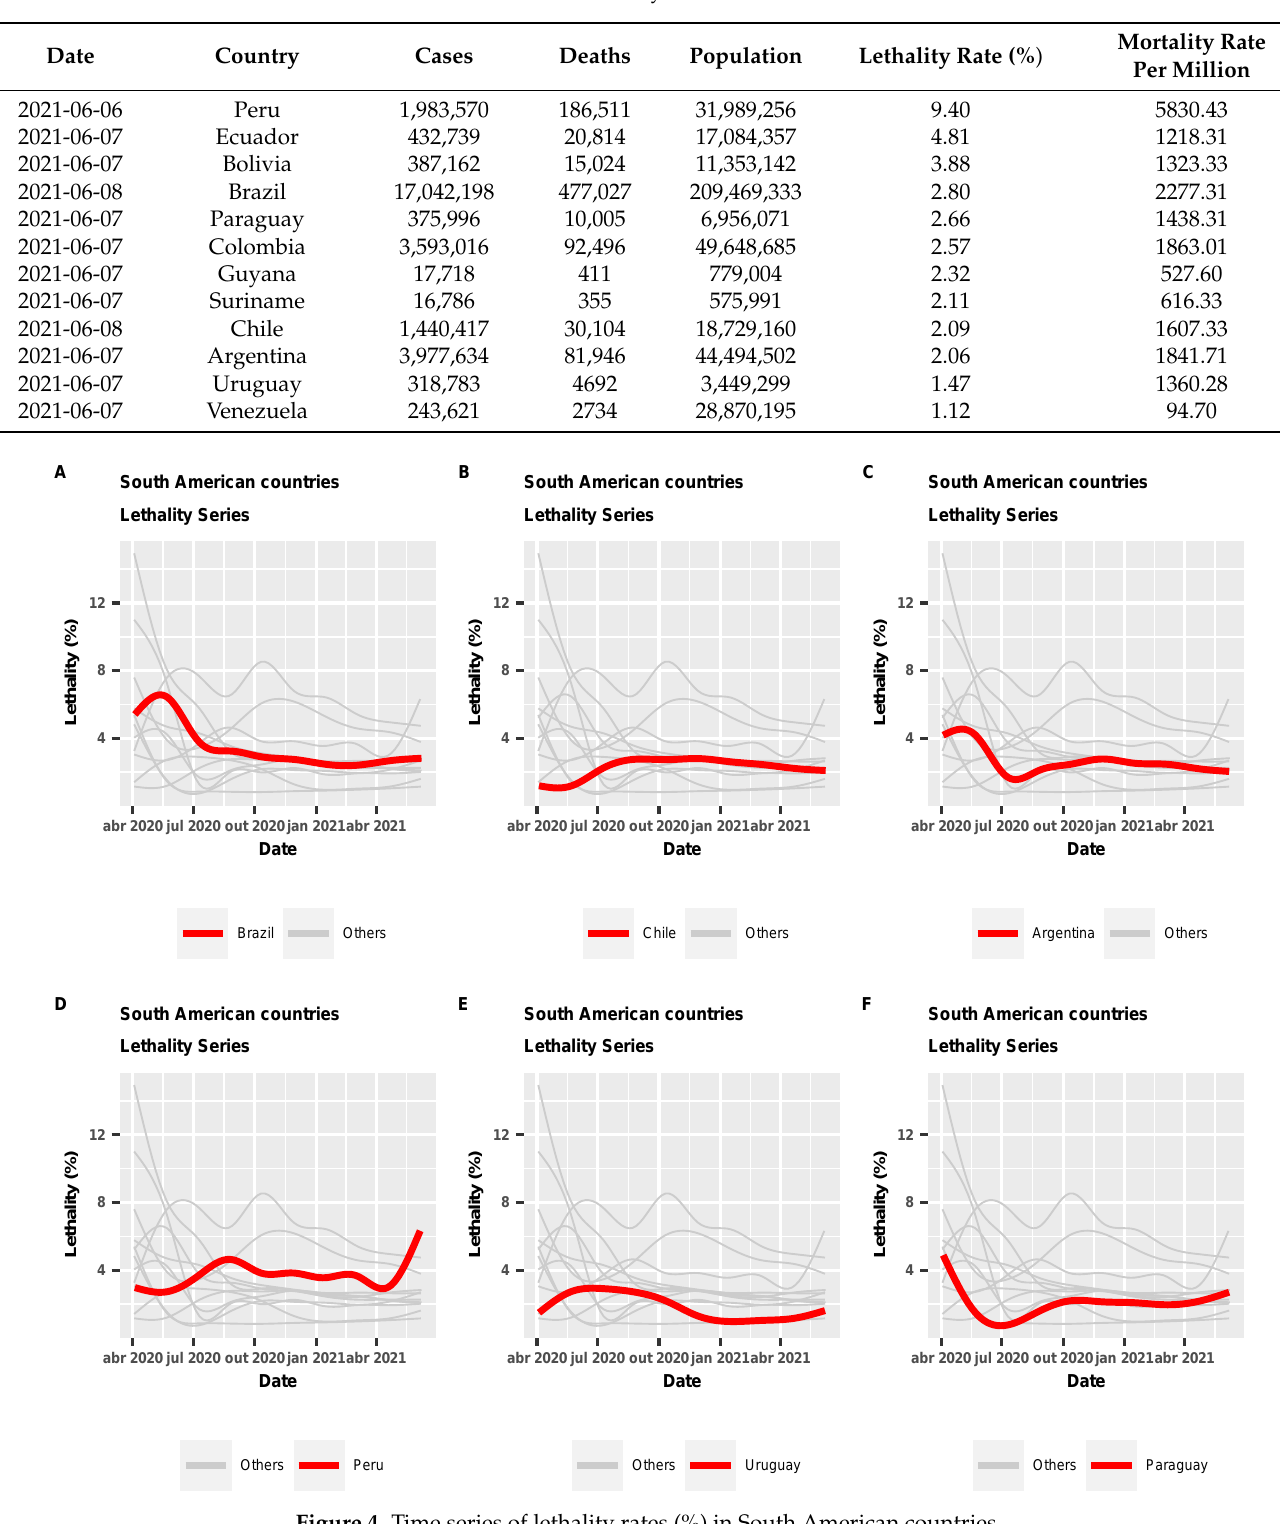
Figure 4. Time series of lethality rates (%) in South American